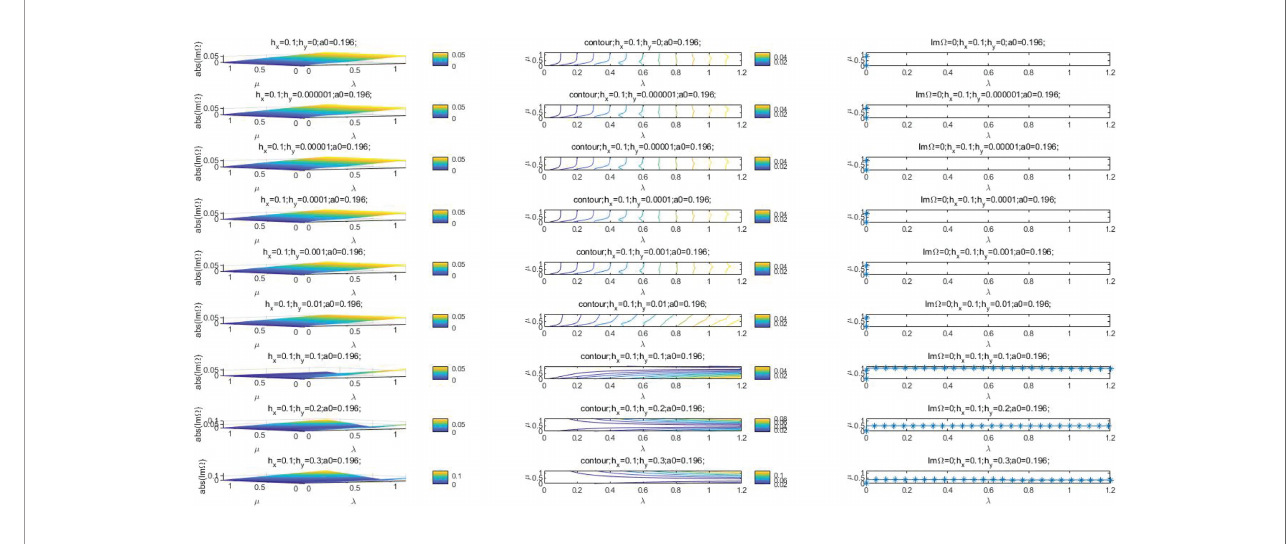
FIGURE 11 | Curves of ǀ Im W ǀ and Im W = 0 for a 0 = 0.196 and ∂ h ∂ x = 0.1.